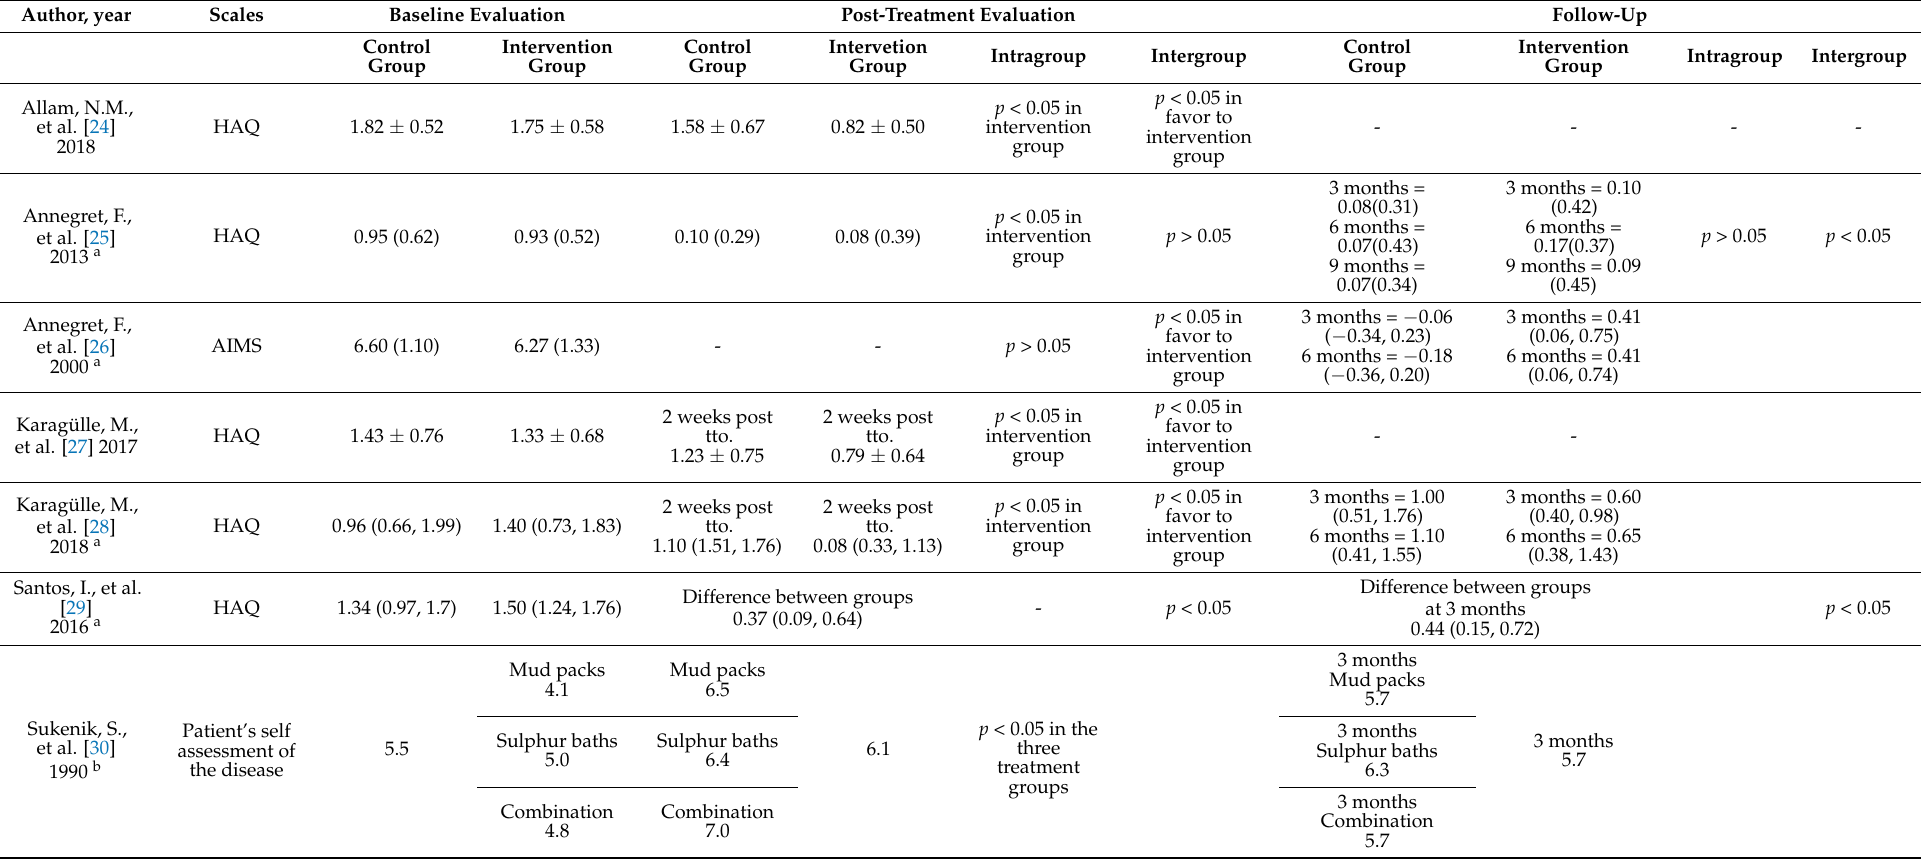
Table 2. Data of the included